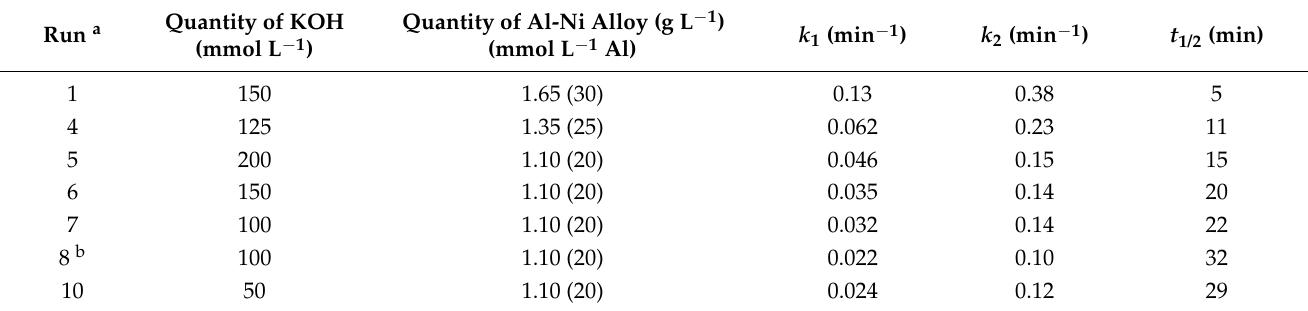
Table 3. Rate constants k 1 , k 2 and reaction half times t 1/2 for different quantities of reagents